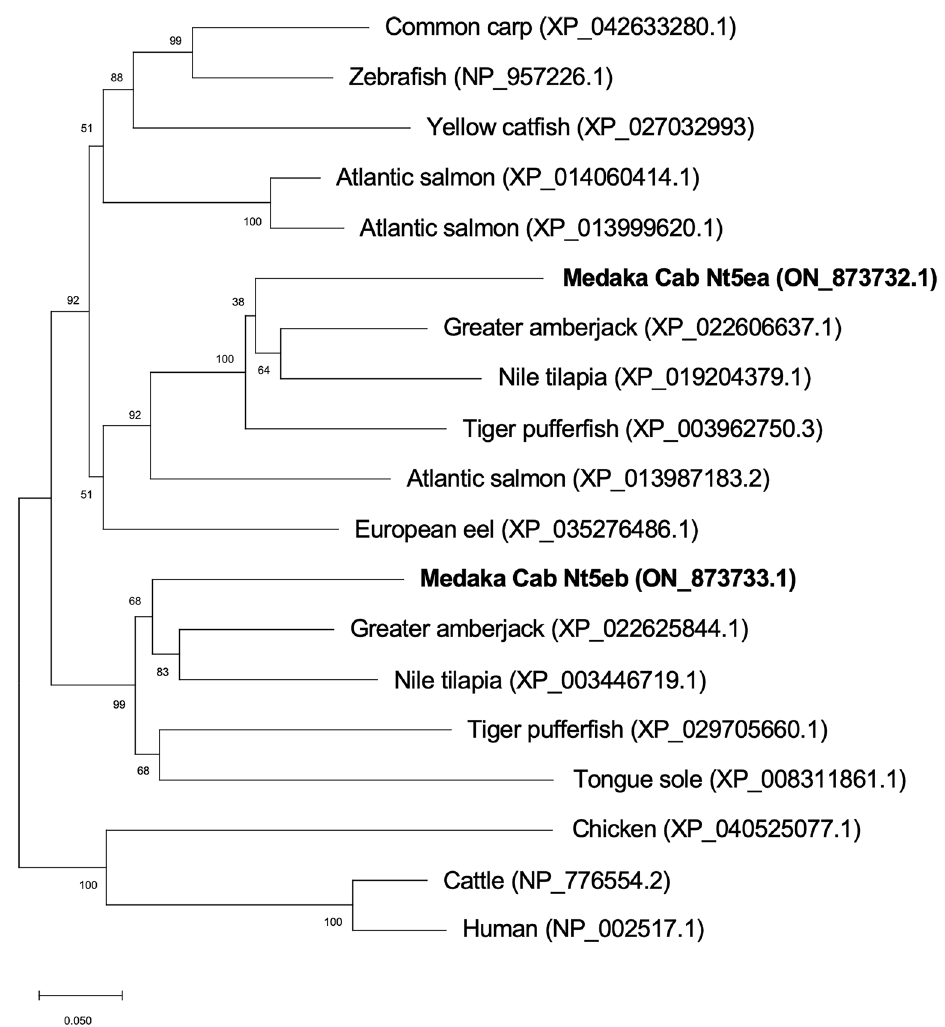
Figure 2. Phylogenetic analysis of Nt5e amino acid sequences. The scale bar shows the substitution rate per residue. Numbers at nodes indicate boot-strap values, as percentages, obtained from 1000 replicates. The gene accession number for each species is provided along with the species